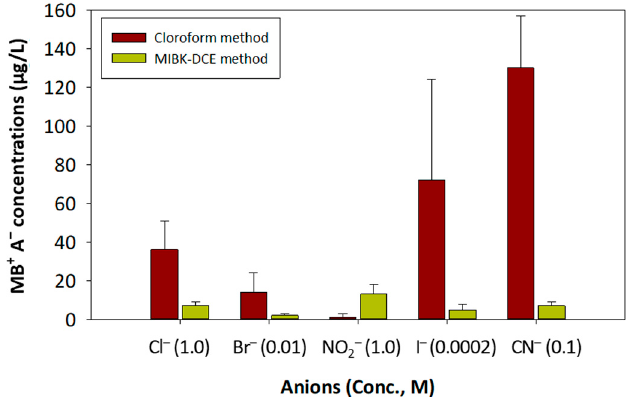
Figure 3. Comparison of the interfering concentrations of several inorganic anions that were meas-